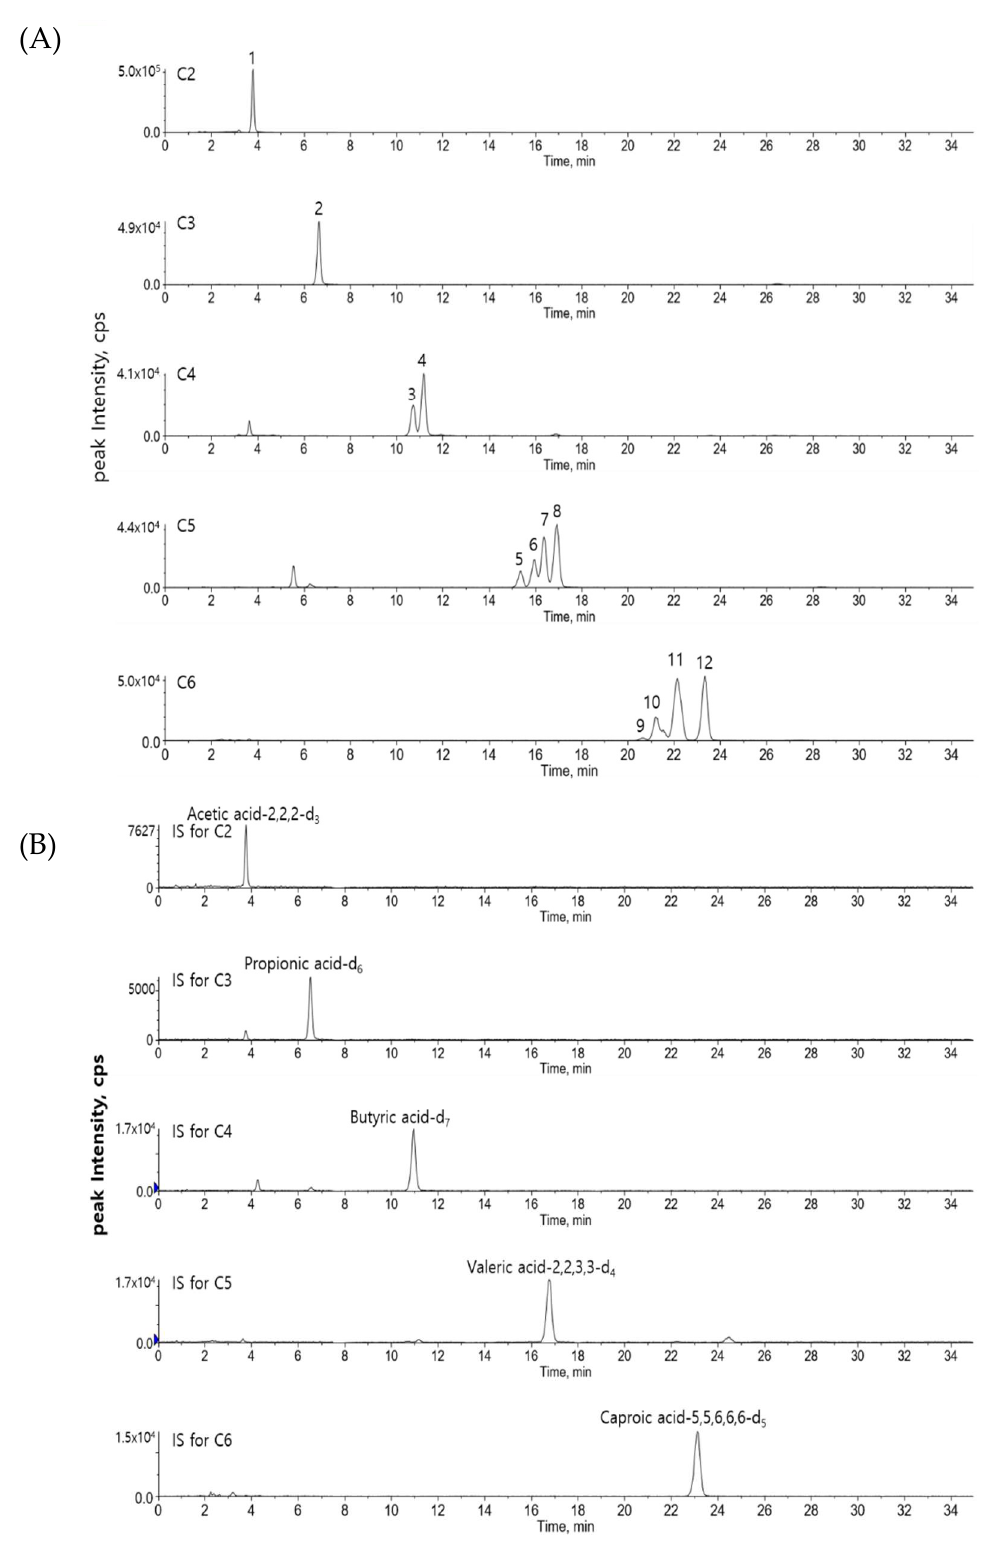
Figure 2. Extracted ion chromatograms of ( A ) SCFAs and ( B ) internal standards in a standard solution (10 µ M). The number on top of each peak represents each SCFA (1: acetic acid; 2: propionic acid; 3: isobutyric acid; 4: butyric acid; 5: 2,2-dimethylpropionic acid; 6: 2-methylbutyric acid; 7: isovaleric acid; 8: valeric acid; 9: 2,2-dimethylbutyric acid; 10: 2-ethylbutyric acid; 11: 2-methylvaleric acid; 12: caproic acid). IS represents internal standard.